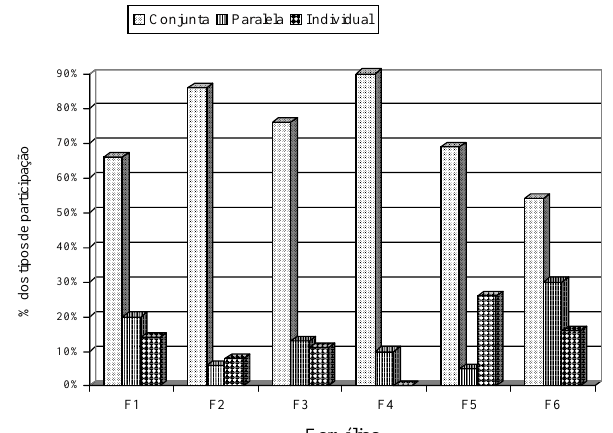
Figura 1. Tipos de participa(cid:231)ªo na atividade, por